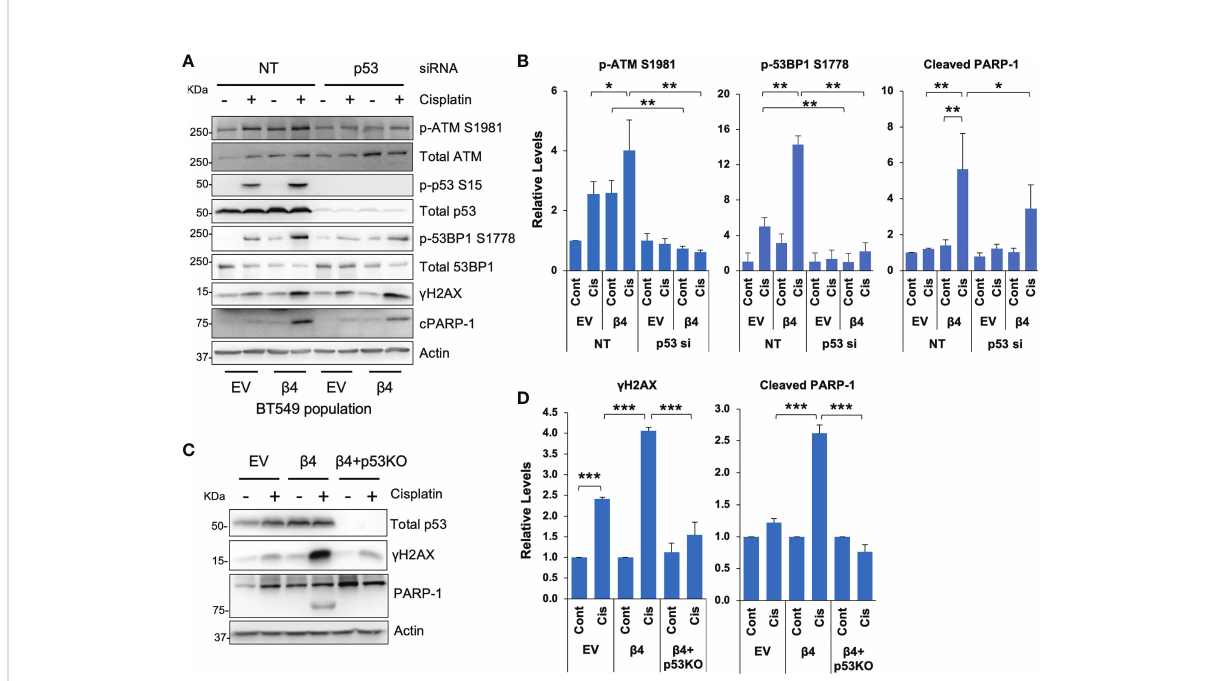
FIGURE 4 Mutant p53 is required for cisplatin-induced ATM and 53BP1 activations and integrin a 6 b 4-mediated sensitivity to cisplatin. P53 was knocked down by siRNA in BT549 EV and BT549 b 4 cells (A, B) or knocked out by CRISPR/Cas9 in BT549 b 4 cells (C, D) , then cells were plated on laminin-1-coated plates and treated with 10µM cisplatin for 24h prior to harvesting for immunoblotting analysis (A, C) . Fold differences were quanti fi ed from three separate experiments, normalized to respective total protein (for p-ATM S1981 and p-53BP1 S1778) or actin for cleavage PARP-1 (cPARP-1) and g H2AX and reported relative to their respective untreated controls indicated (B, D) . *p < 0.05, **p < 0.005, ***p <